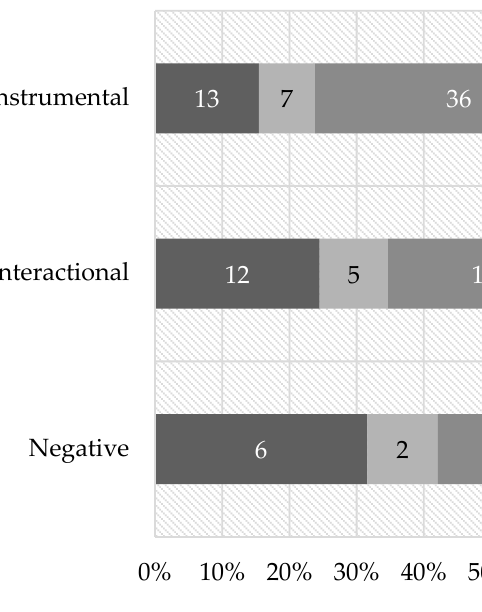
Figure 3. Proportion of mentions of each source of support by support type (n = 20).